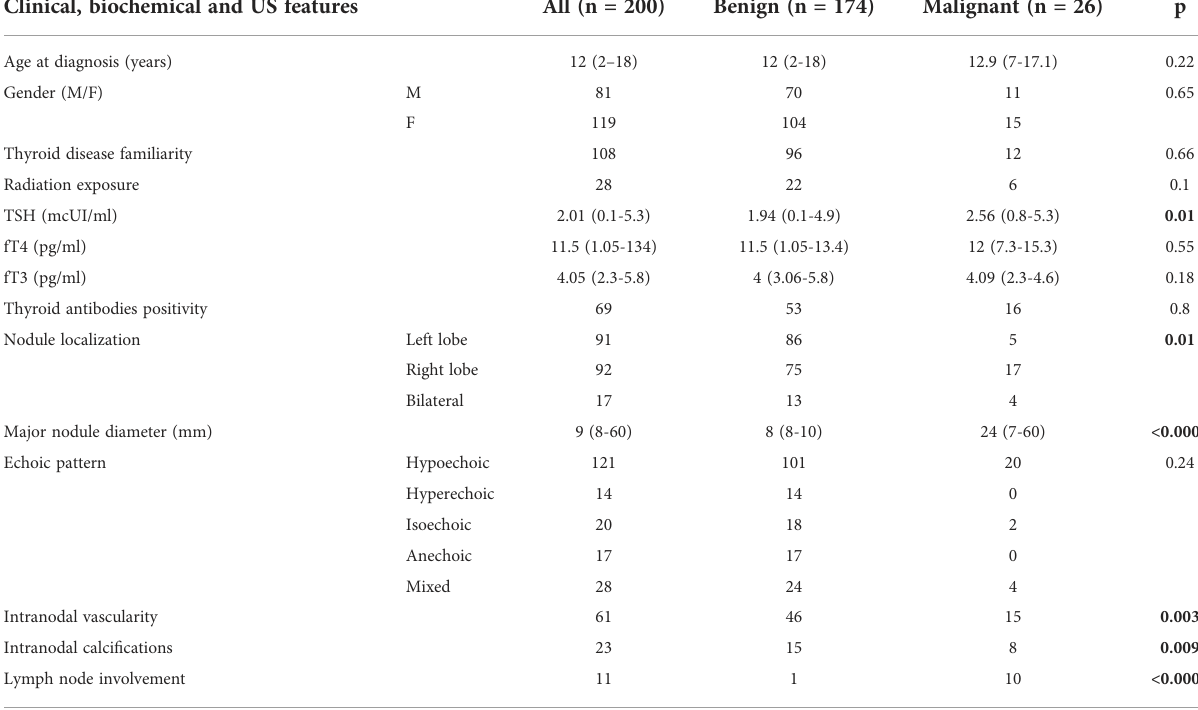
TABLE 1 Clinical, biochemical and US features of all subjects (N=200) with thyroid